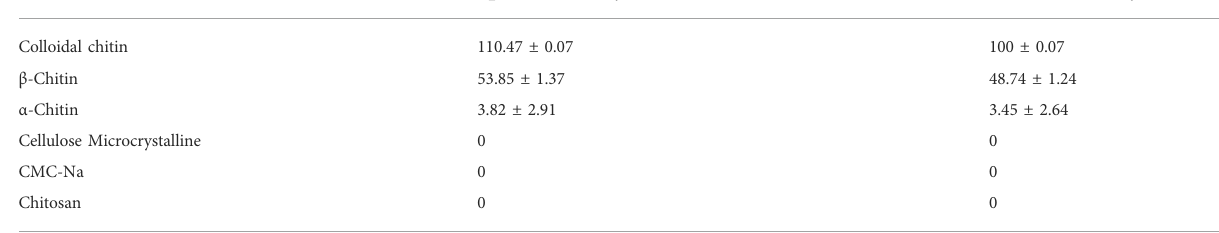
TABLE 3 Substrate speci fi city of Δ 30 Af ChiJ.